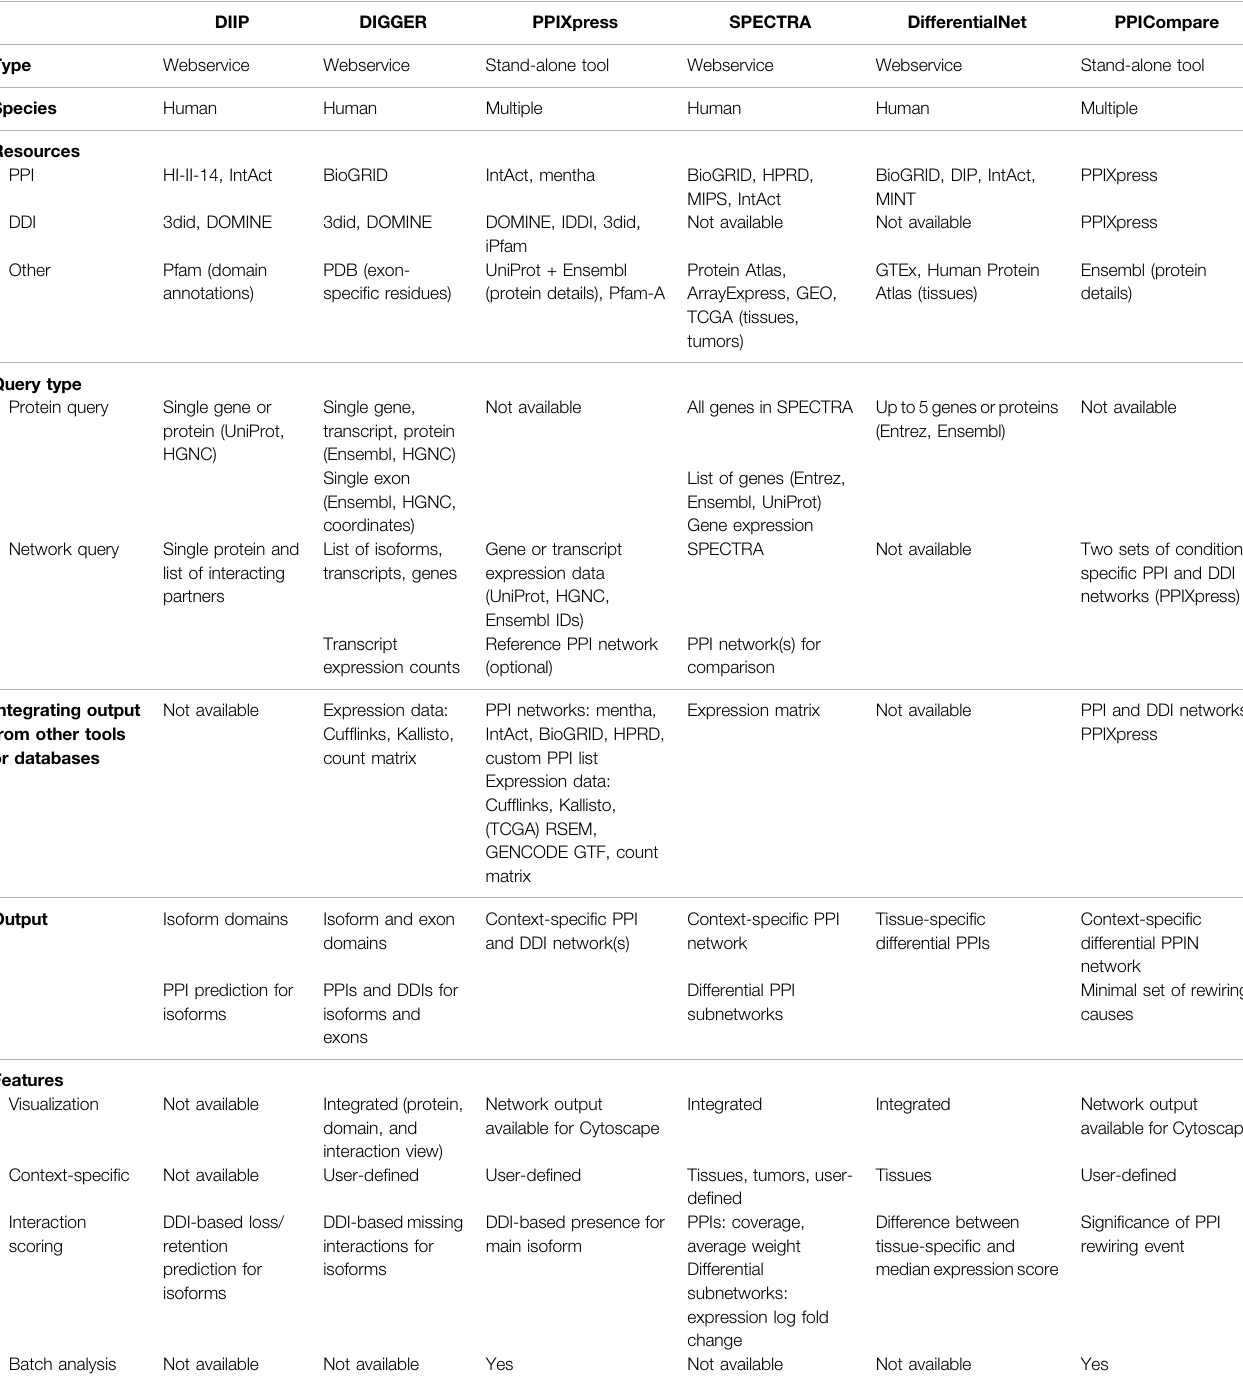
TABLE 2 | Features of software tools and webservices enabling the generation and analysis of domain- or isoform-level protein-protein interaction data (DIIP, DIGGER, PPIXpress), as well as the comparison of interaction rewiring (SPECTRA, DifferentialNet,